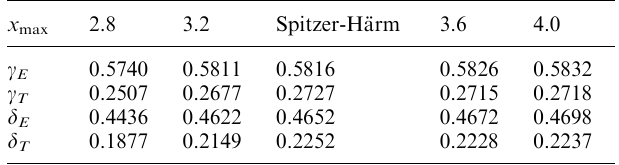
and compared with max = max